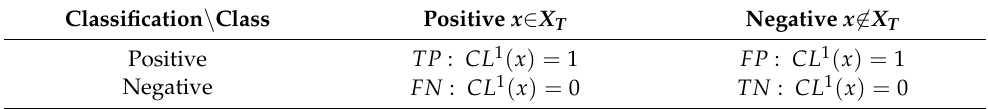
(Table 2): True Positive ( 𝑇𝑃 ), True Negative ( 𝑇𝑁 ), False Positive ( 𝐹𝑃 ), False Negative ( 𝐹𝑁 ). Table 2. Binary Classification Outcomes. Classification\Class Table 2. Binary Classification Outcomes.